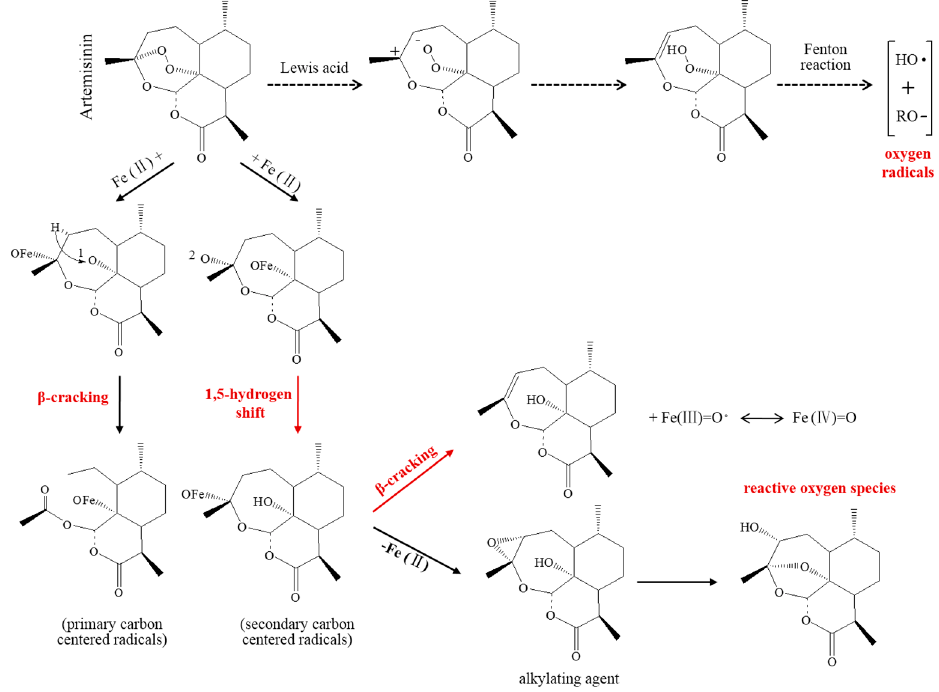
Figure 2. Speculated mechanisms of artemisinin generating oxidative damage via ferrous ion-mediated reactions: the β -cracking and 1,5-hydrogenmigration are primary pathways, and the Lewis is a secondary pathway.